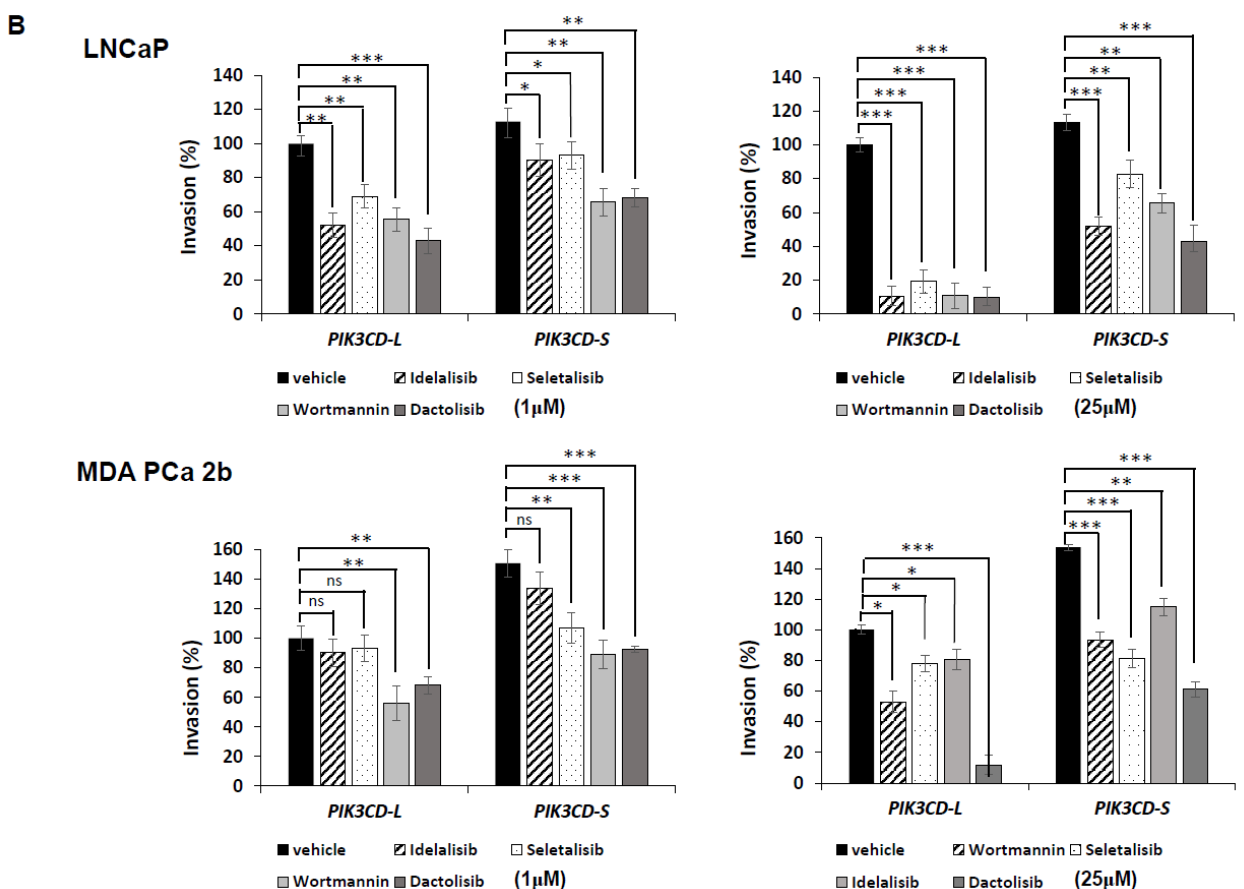
Figure 3. The full-length PI3K δ -L is highly sensitive to the PI3K inhibitors, but PI3K δ -S isoform exhibits resistance to the PI3K inhibitors. ( A ) Apoptosis activity assays, based on caspase 3/7 activities, in PIK3CD-L - and PIK3CD-S -expressing LNCaP and MDA PCa 2b cells under treatment of Idelalisib, Seletalisib, Wortmannin, and Dactolisib at 0, 1, 10, 25 μM. ( B ) Invasion assays in PIK3CD-L - and PIK3CD-S -expressing LNCaP and MDA PCa 2b cells under treatment of Idelalisib, Seletalisib, Wortmannin, and Dactolisib at 0, 1, 10, 25 μM. The data for both apoptosis and invasion assays were calculated from 3–4 independent experiments with duplicates, and the data were plotted as mean ± SEM. * , ** , *** p- values (<0.05, 0.01, <0.001) were determined based on one-way ANOVA with Tukey’s post hoc test. ns: not significant.